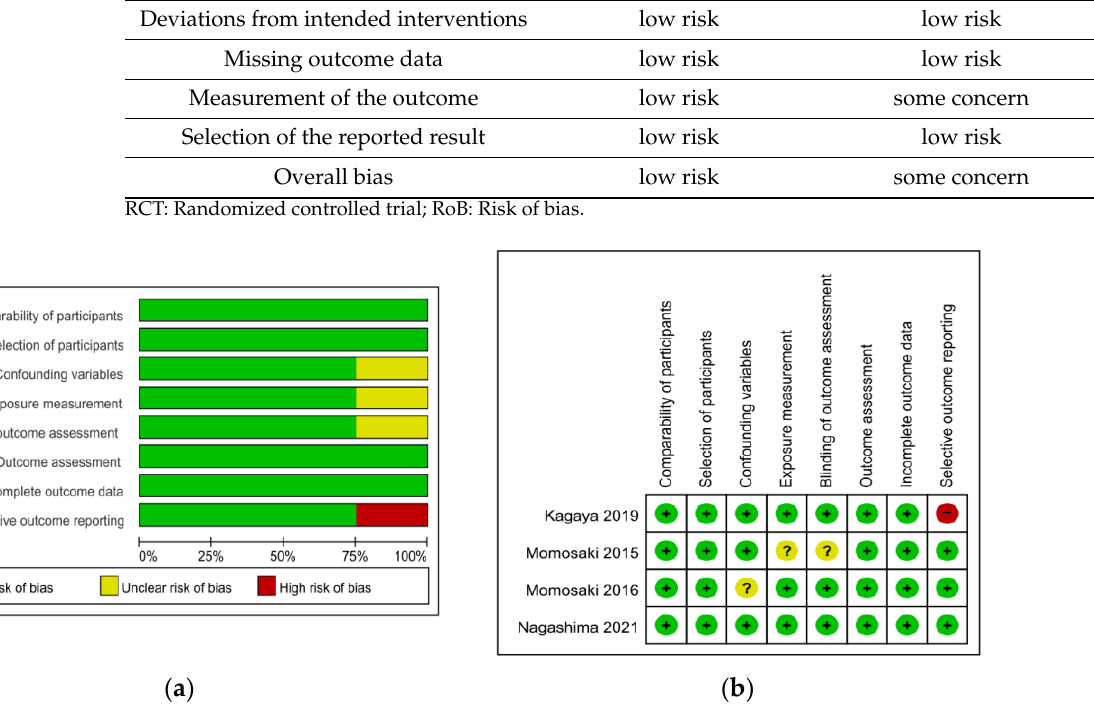
Figure 2. Quality assessment of the included studies using ROBANS. ( a ) ROBANS graph and ( b ) ROBANS summary; +: Low risk of bias; ?: U nclear risk of bias; −: High risk of bias; ROBANS: Risk of bias assessment tool for non-randomized studies.